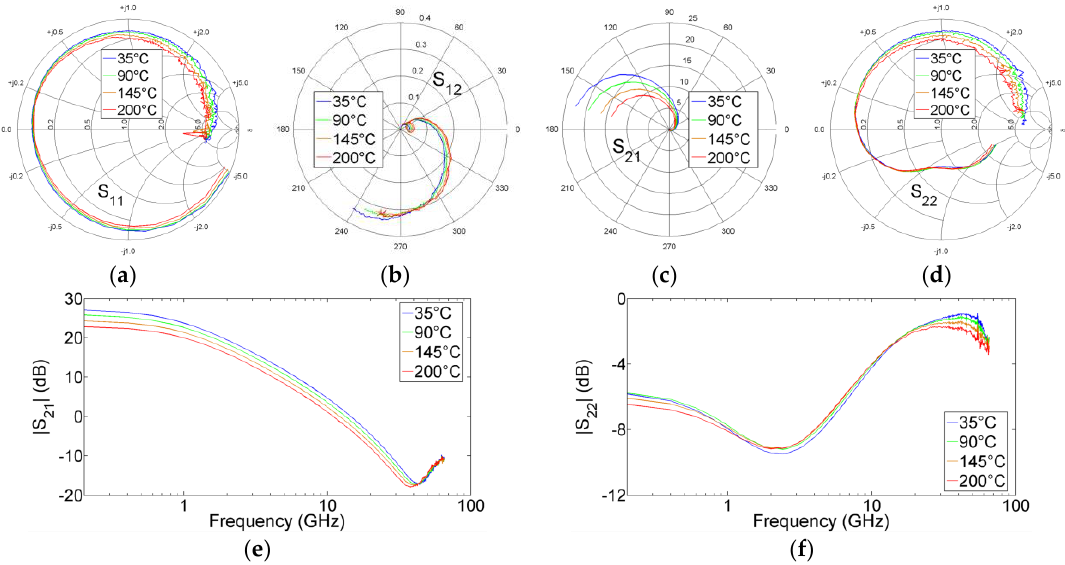
Figure 3. Measured ( a ) S 11 , ( b ) S 12 , ( c ) S 21 , ( d ) S 22 , ( e ) magnitude of S 21 , and ( f ) magnitude of S 22 from 0.2 to 65 GHz for a GaN HEMT at V DS = 30 V and V GS = −3 .1 V under four ambient temperatures: 35 °C, 90 °C, 145 °C, and 200 °C.